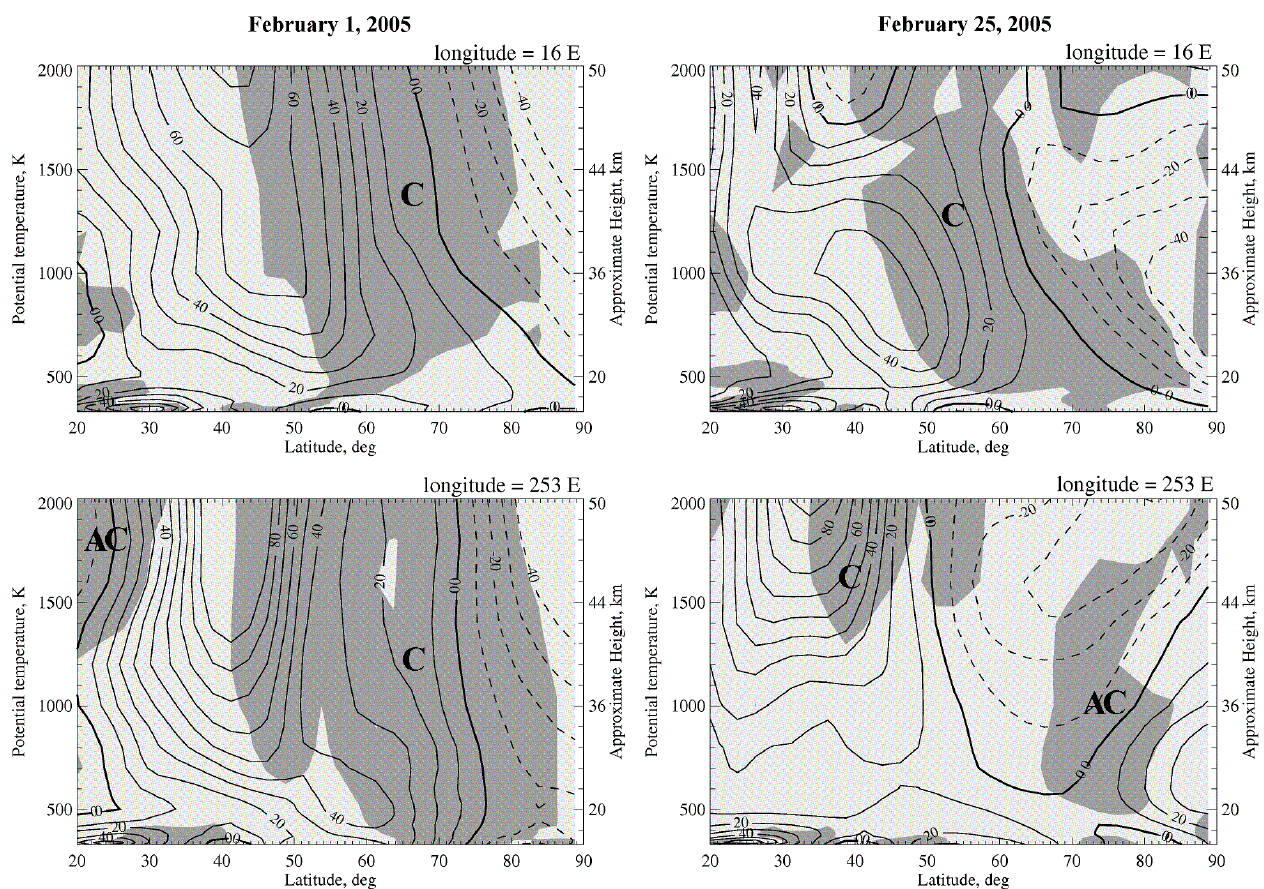
Fig. 3. Zonal winds from low to high latitudes at the chosen Canada-US (253 ◦ ± 12 ◦ E) and Scandinavia-Europe (16 ◦ ± 12.5 ◦ E) sectors: the two most disturbed intervals of the winter, centred on 1 and 25 February, are shown. Westerly winds are positive and therefore out of the plane of the page. The darker hatching/grey is for the negative values of the Q-diagnostic, where solid rotation dominates; cyclonic C and anti-cyclonic AC regions are indicated. The hemispheric edges of the polar cyclonic vortex are very close to the southern boundaries of the Q< 0 cyclonic areas, and the hemispheric edge of the anticyclone is also close to the southern boundary of Q< 0. Data from MetO have been